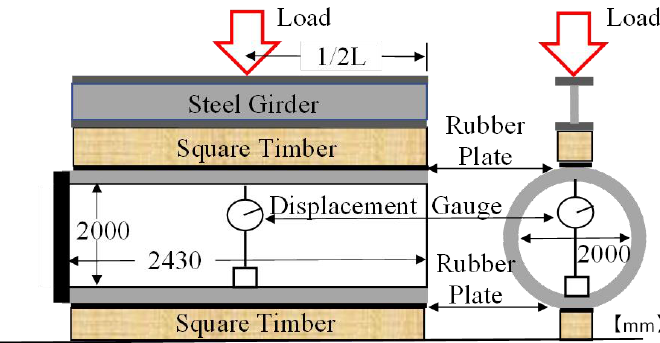
Figure 12. Loading test for mock-up specimen (Hume pipe A).